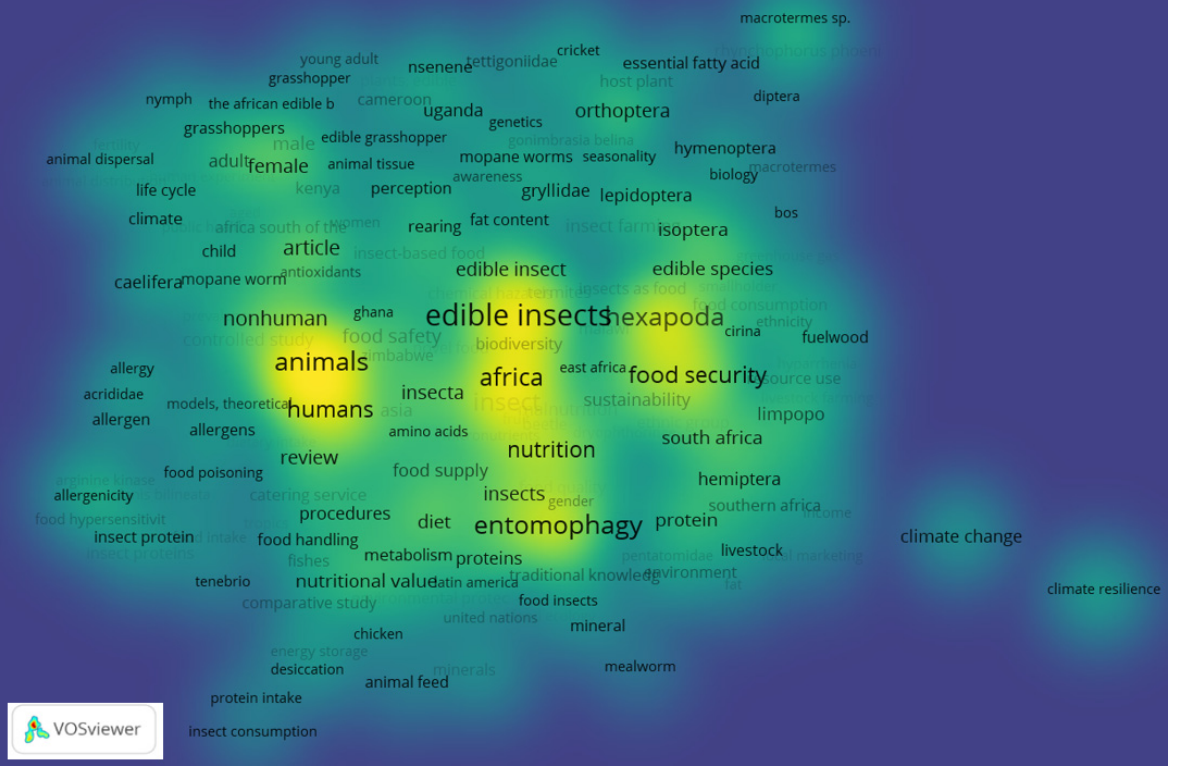
Figure 5. Output of term co-occurrence on edible insect studies in Africa. Figure 6 highlights the country-level co-authorship associations established by the study. The red cluster shows that co-authorships were mostly among researchers from Australia, Nigeria, Zimbabwe, the United States of America, Zambia and the Netherlands,